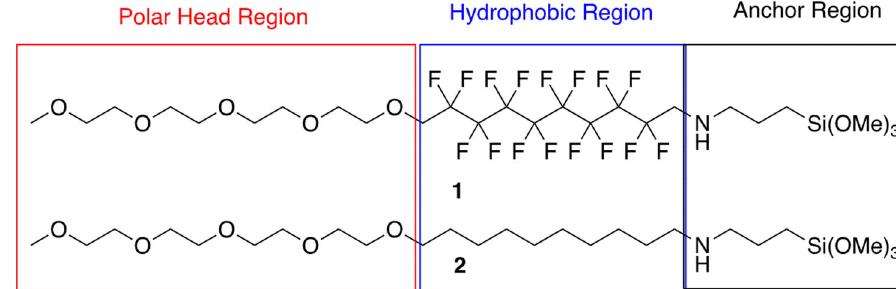
Fig. 1 Silane structures. Structures of amphiphilic silanes 1 (F16-4PEG) and 2 (H16-4PEG).